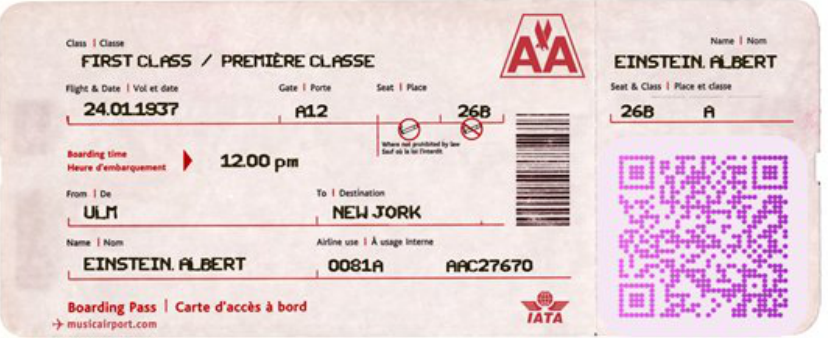
Figure 3. Boarding card of Albert